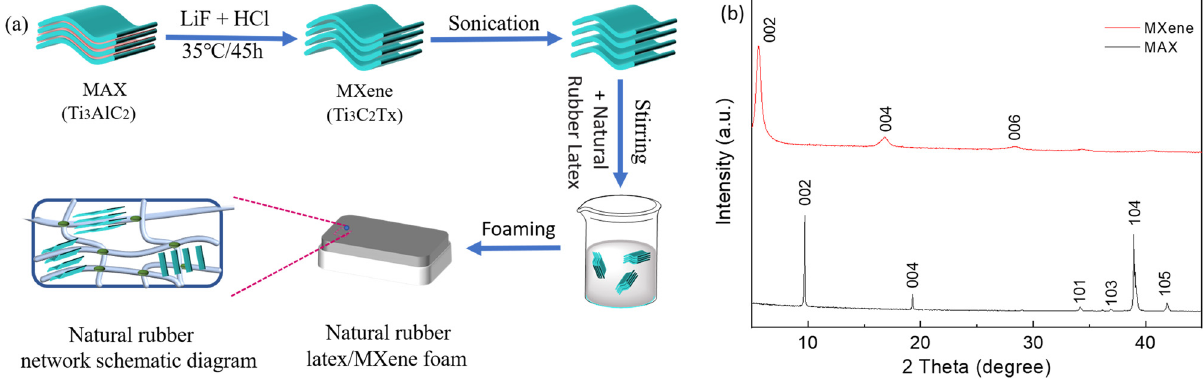
Figure 1: ( a ) Schematic illustrating the fabrication process of NRMF; ( b ) XRD patterns of MAX ( Ti 3 AlC 2 ) and exfoliated MXene ( Ti 3 C 2 T x )